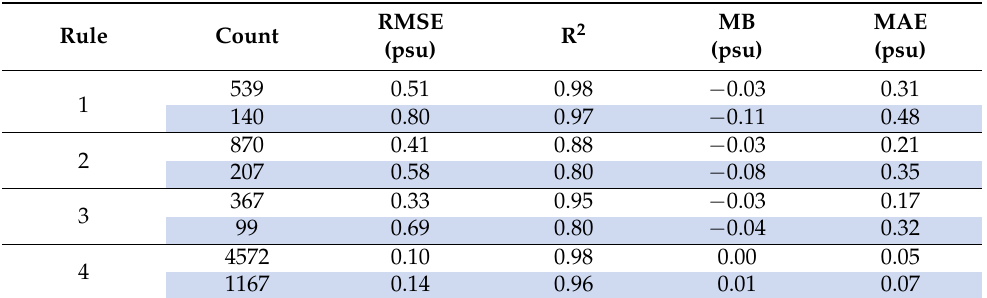
Table 4. Accuracy verification of each rule model for both train and validation, the validation result was listed with blue background.